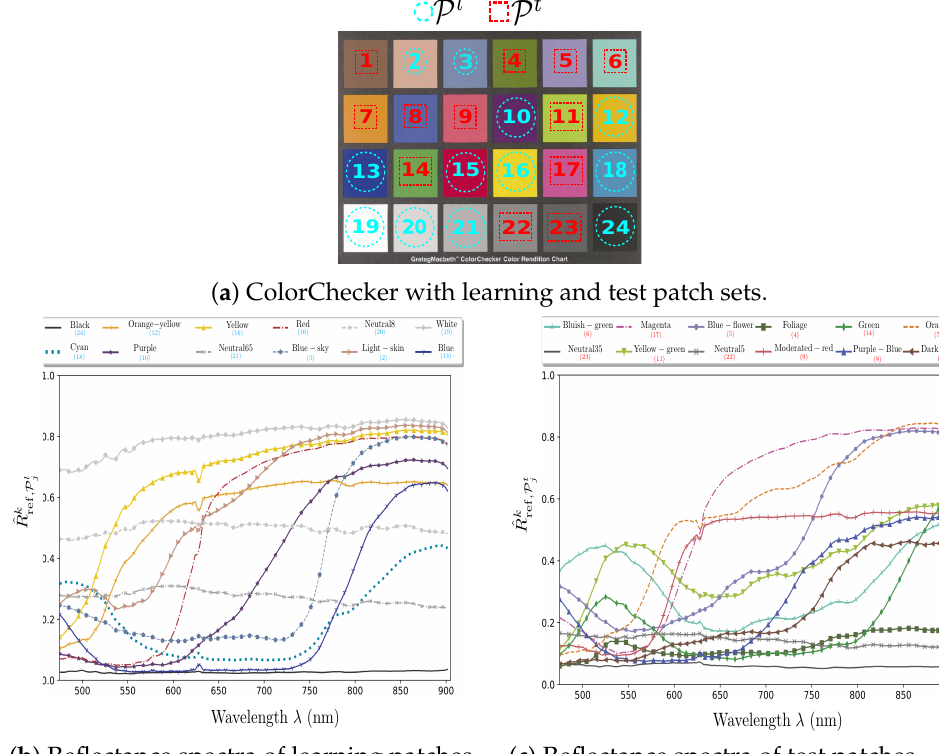
( b ) Reflectance spectra of learning patches. ( c ) Reflectance spectra of test patches. Figure 5. ( a ) ColorChecker patch numbers and ( b , c ) reference reflectance